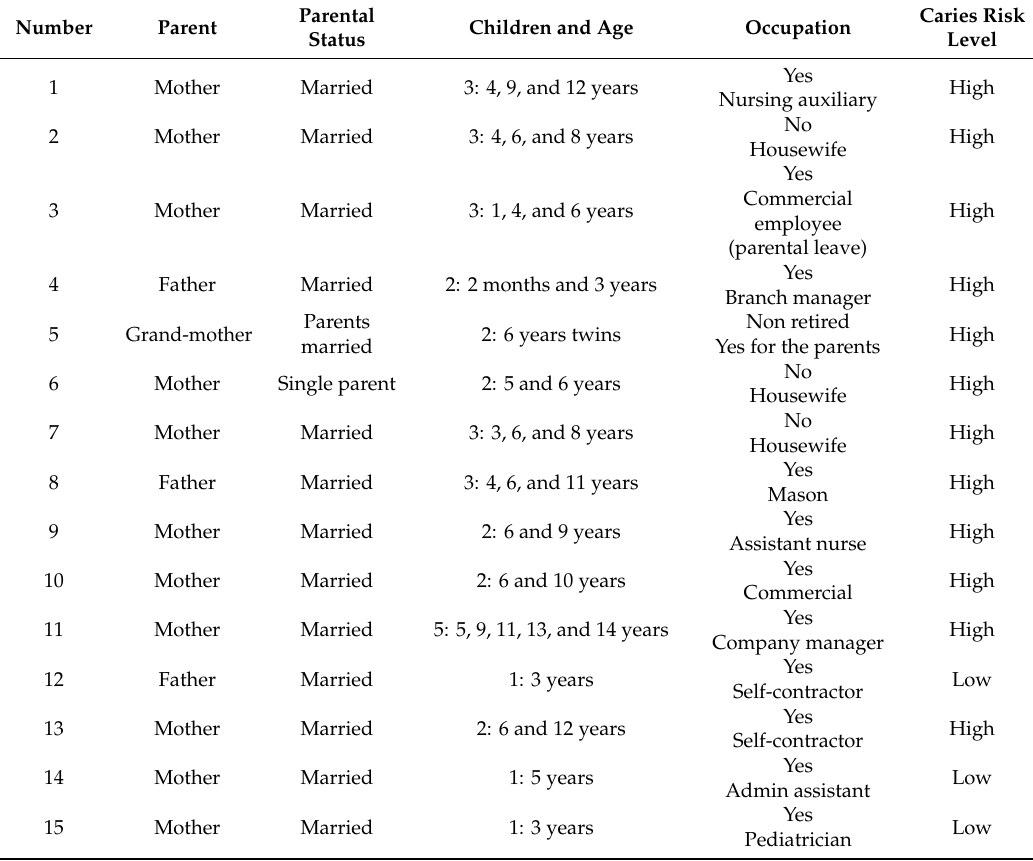
Table 1. Description of participants’